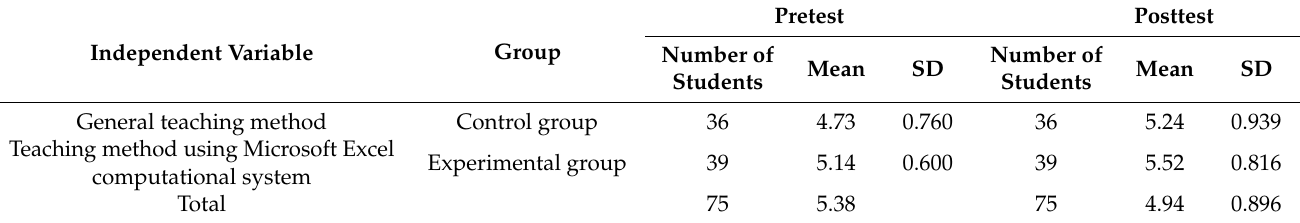
Table 2. Descriptive statistics of the learning effectiveness of the two groups of students.